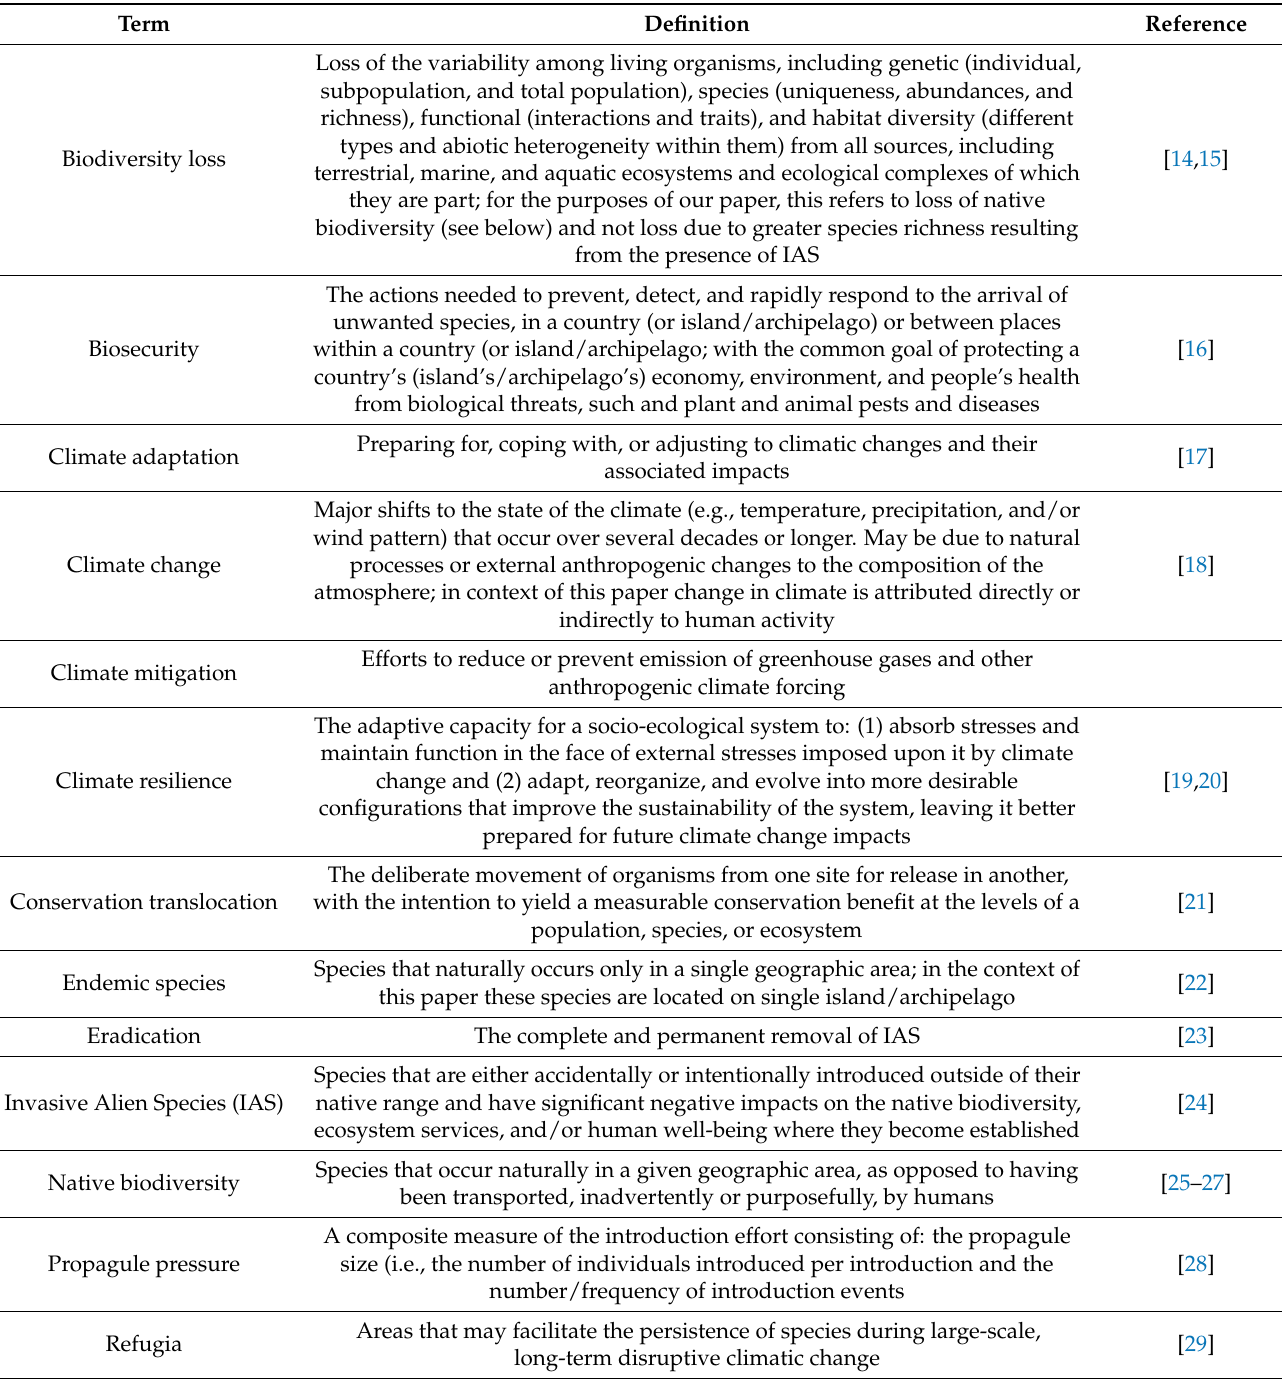
Table 1. Definitions and references of key terms used in the paper that may not be commonly used or have may have alternate meanings among different scientific disciplines, practitioners, and/or climate